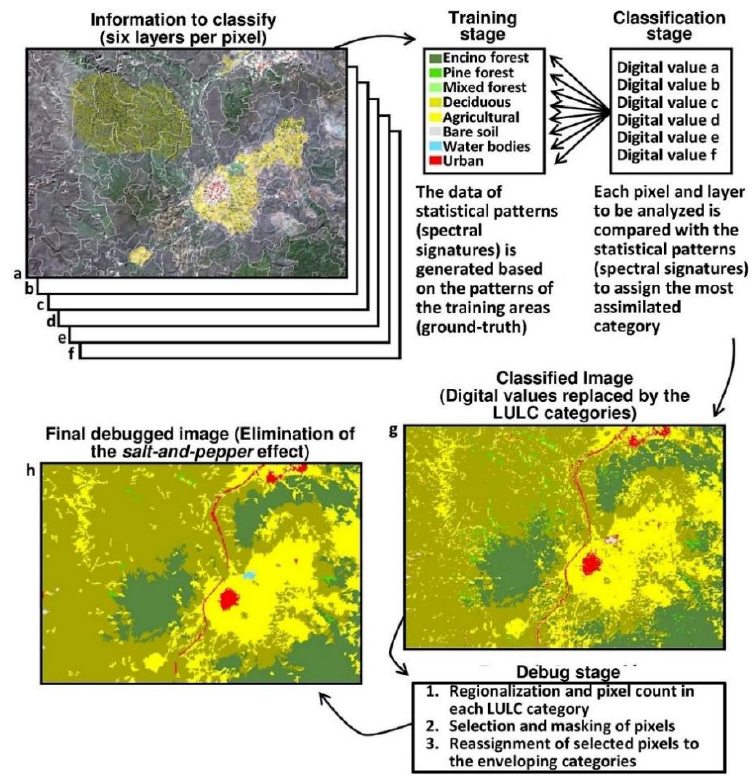
Figure 4. Overview process of supervised MaxLike classification and the LULC map for the base date. Classified layers: ( a ) Segmented image, ( b – d ) First three PCs, ( e ) NDVI, ( f ) DEM, ( g ) resulting image from classification, and ( h ) Final image.